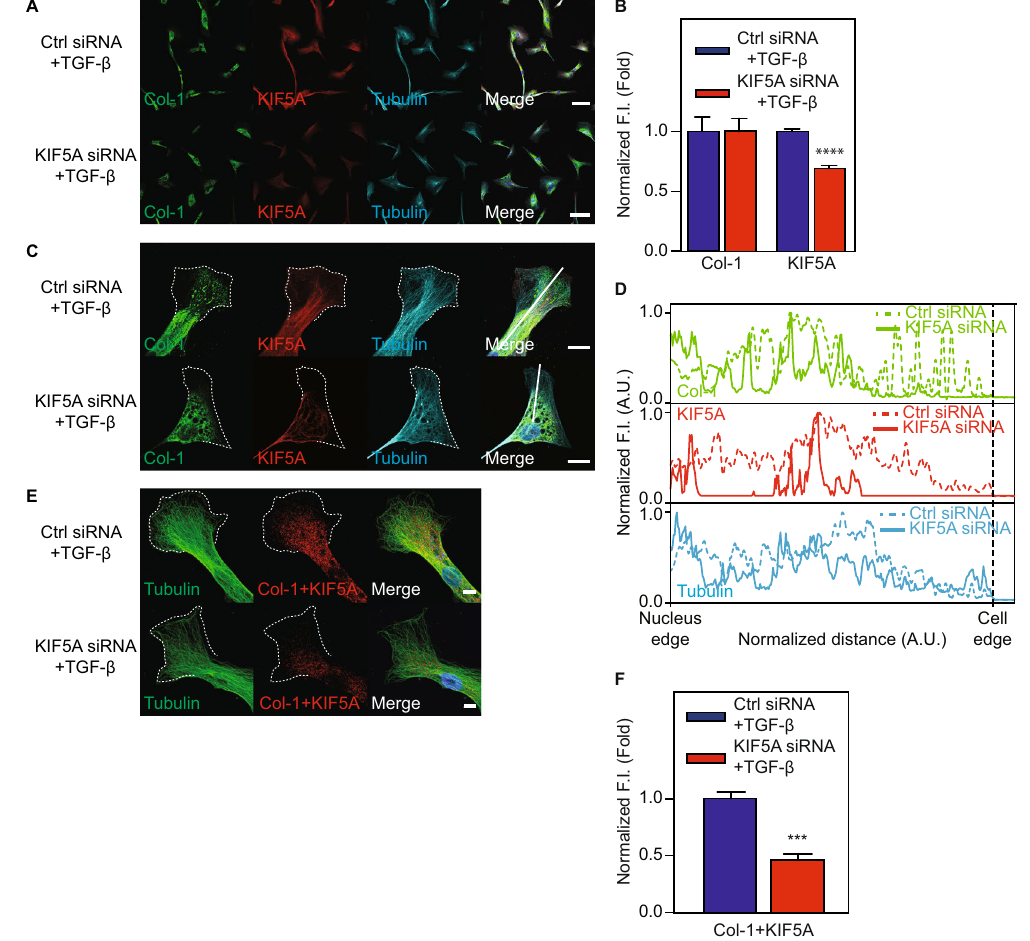
Figure 5. Effect of KIF5A KD on collagen transportation in HPMC. ( A ) Confocal images of multiple HPMCs treated with control siRNA and KIF5A siRNA after TGF- β stimulation. Merge images include blue nucleus signal. Scale bar; 60 μ m. ( B ) Quantitative analysis of average fluorescent intensity inside the cells of A (n = 11 cells for control siRNA, n = 9 cells for KIF5A). **** P < 0.0001 vs basal level. F.I., Fluorescent Intensity. ( C ) Confocal images of single HPMC treated with control siRNA and KIF5A siRNA after TGF- β stimulation. Merge images include blue nucleus signal. White dotted lines indicate the edge of cells. Scale bar; 20 μ m. ( D ) Quantitative line profile along white lines of C. F.I., Fluorescent Intensity. ( E ) Confocal images with proximity-ligation assay of single HPMCs treated with control siRNA and KIF5A siRNA after TGF- β stimulation. White dotted lines indicate the edge of cells. Scale bar; 10 μ m. ( F ) Quantitative analysis of average fluorescent intensity inside the cells of E (n = 4 cells). **** P < 0.0001 vs basal level. F.I., Fluorescent